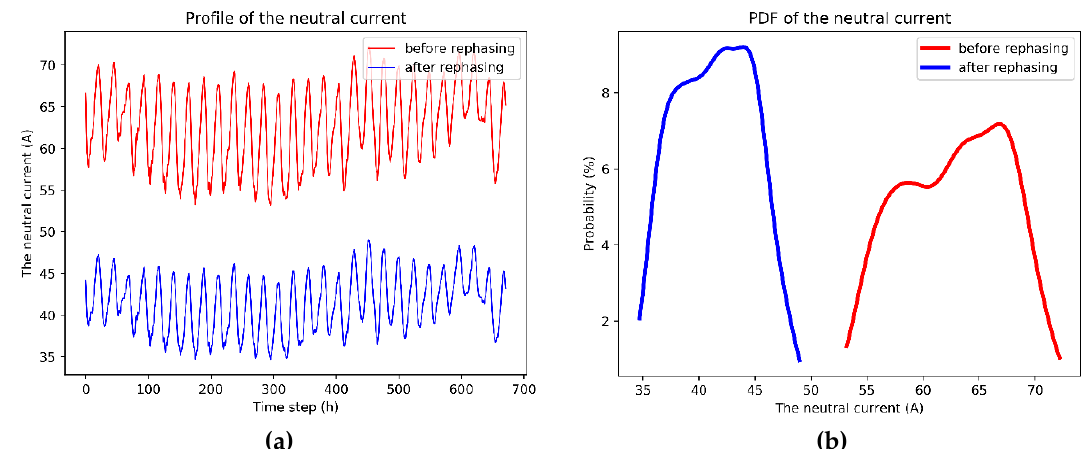
Figure 11. The single line diagram of LCO protective relay in the three-phase, four-wire distribution systems.